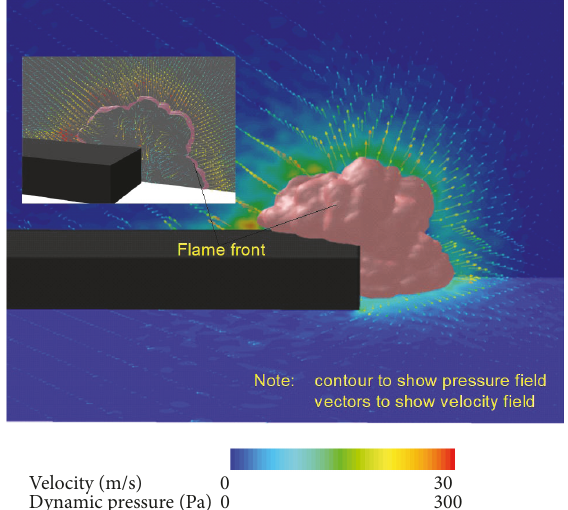
Figure 12: Comparison of pressure field, flame surface, and velocity field ( 𝜑 = 1.1 , t =